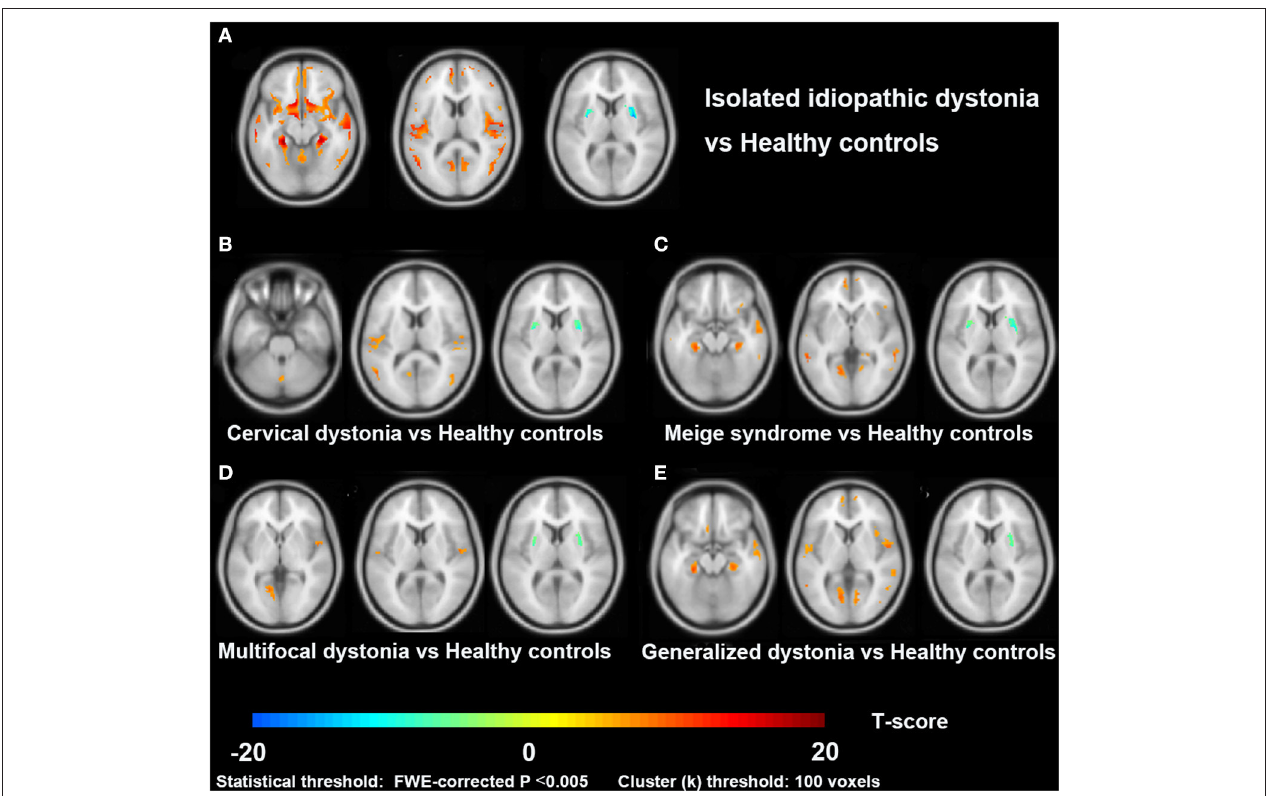
FIGURE 1 | Cross-sectional comparisons between patients with dystonia and healthy controls in the VBM study. Slice view (A–E) of gray matter volume changes in patients with isolated idiopathic dystonia, and also in each patient subgroup (cervical dystonia, Meige syndrome, multifocal dystonia, and generalized dystonia), compared to healthy